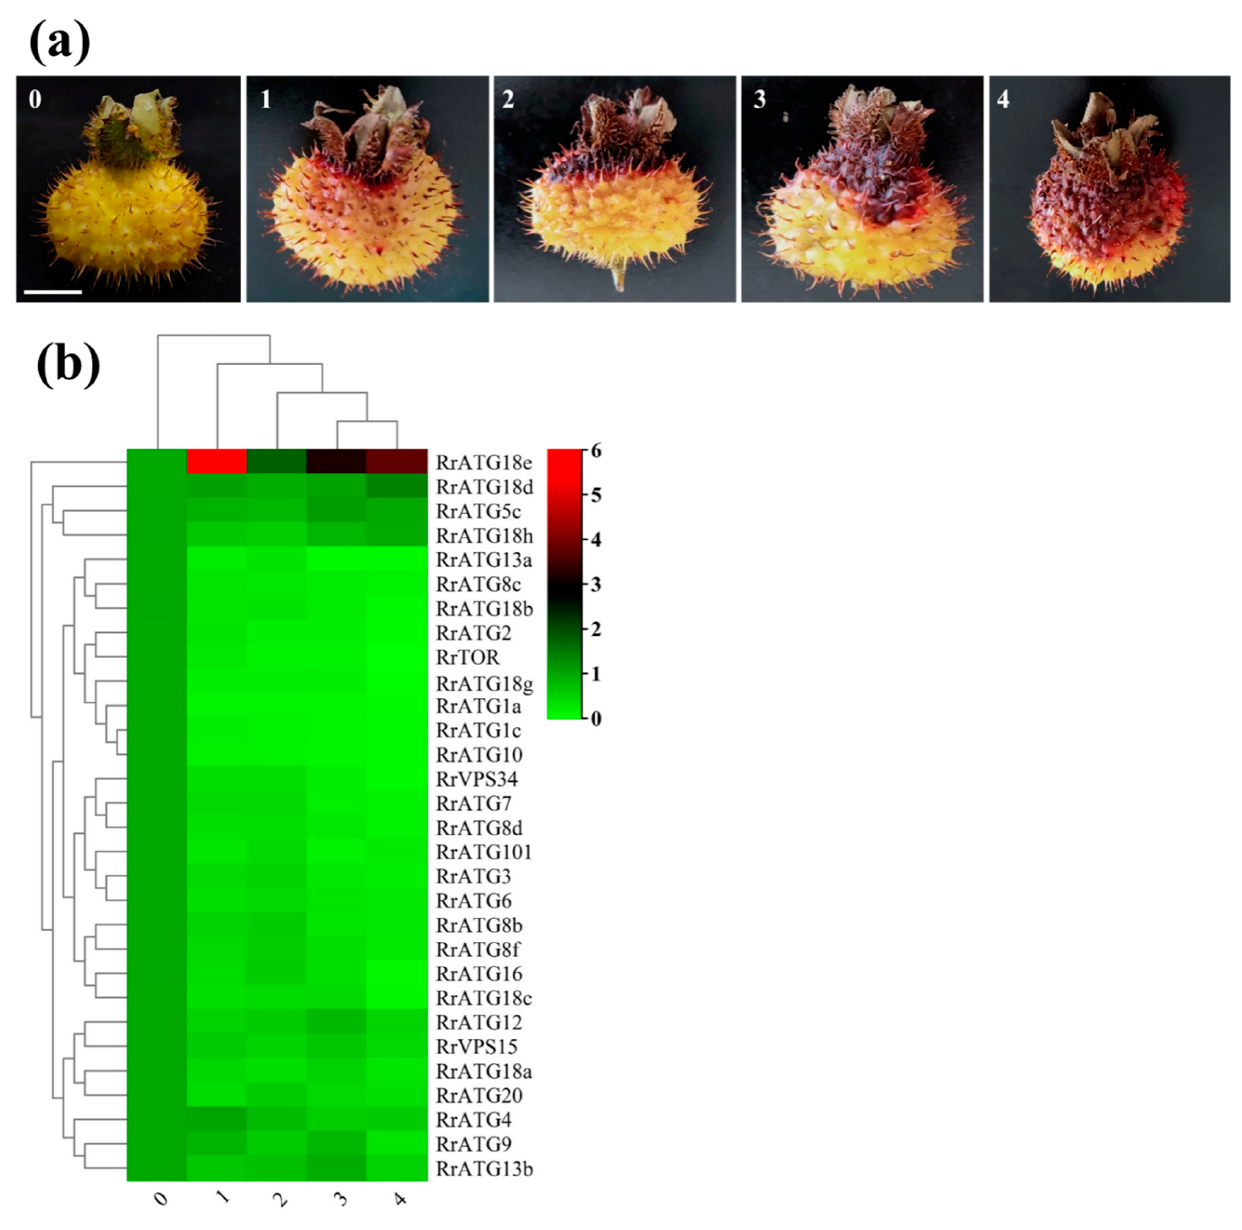
Figure 5. Schematic diagram and expression of RrATGs in fruits with different grades of TRD occurrence. ( a ) Grade 0 is no incidence, grade 1 is 1–10%, grade 2 is 11–25%, grade 3 is 26–50%, and grade 4 is >50% the proportion of fruit spot size to the total surface area of the fruit, respectively. Bar = 1 cm. ( b ) Heat map showed the corresponding expression levels of RrATGs in diseased fruits of different grades, and the expression levels of healthy fruits were considered as ‘1’, red and green represent the higher and lower expression levels, respectively.